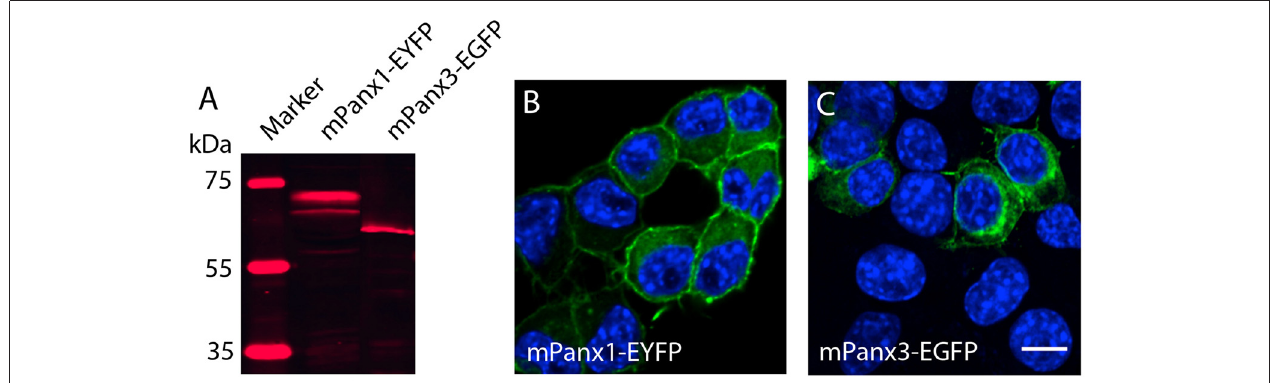
FIGURE 7 | Panx1 and Panx3 localization in Neuro2A cells. (A) Western blot showing Panx1-EYFP and Panx3-EGFP proteins 48 h after transient transfection into Neuro2A cells. (B,C) Merged images, including DAPI staining of nuclei (blue), and Panx1-EYFP (Left) and Panx3-EGFP (Right) localization (green) in Neuro2a cells. Scale bars = 10 µ m.